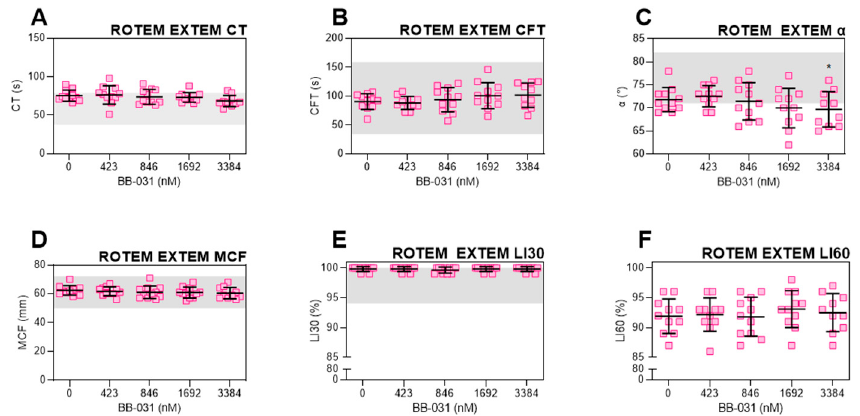
Figure 3. Bleeding risk assessment. ROTEM EXTEM was performed to assess the risk of bleeding with increasing doses of BB-031. Selected ROTEM parameters are displayed: ( A ) clotting time (CT), the start of measurement until amplitude reaches 2 mm, ( B ) clot formation time (CFT), the time between initiation of clotting until clot firmness reaches 20 mm amplitude, signifying fibrin polymerization and clot stabilization, ( C ) alpha angle ( α ), the angle between the x axis and tangential line to the curve at 2 mm, describing clot kinetics, ( D ) maximum clot firmness (MCF), the highest amplitude reached reflecting maximal clot strength, ( E ) lysis index at 30 min (LI30), and ( F ) lysis index at 60 min (LI60s). Both LI30 and LI60 describe the progress, where 100% reflects no lysis progression. N = 10. Individual data points are shown. Error bars represent mean ± standard deviation (SD). Gray bands represent reference ranges for CT, CFT, MCF, α , and LI30 in healthy adults (instructions for use (IFU) and PMID 15870552). Reference range is not available for LI60. * p < 0.05.